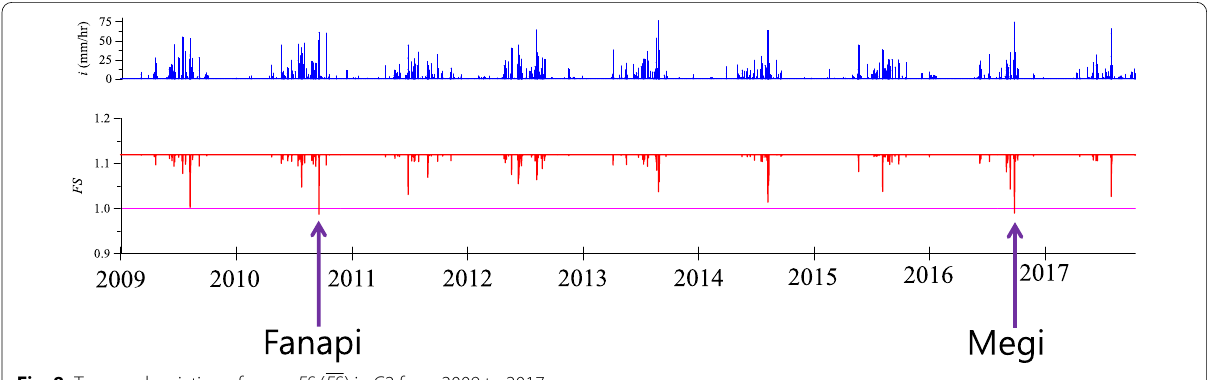
Fig. 8 Temporal variation of mean FS ( FS ) in C2 from 2009 to